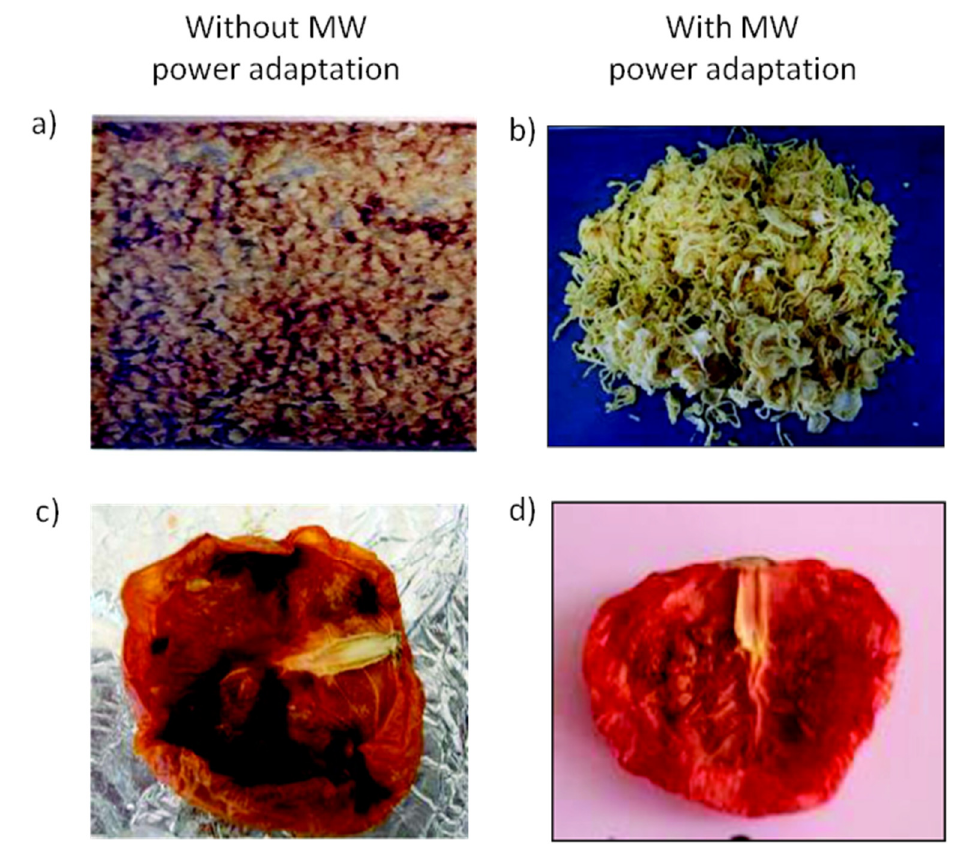
Figure 1. Effect of controlled microwave (MW) power on dried product [44]: ( a ) onion treated with MW without power adaptation; ( b ) onion with power adaptation; ( c ) tomato treated with MW without power adaptation; ( d ) tomato with power adaptation.